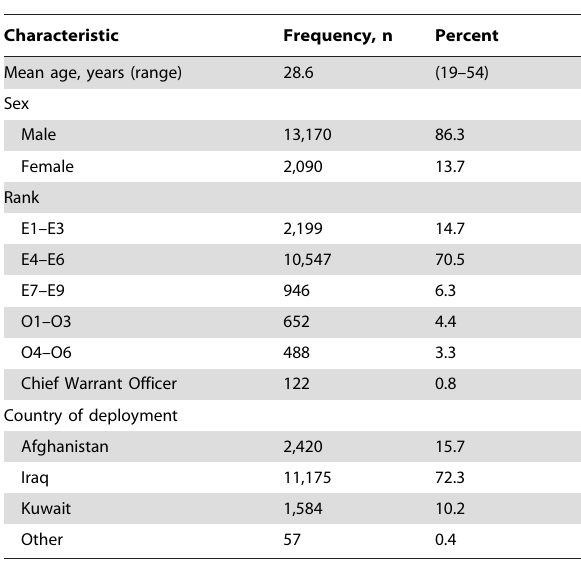
Table 2. Multivariate negative binomial regression of the association between rate of self-reported respiratory infection and covariates, voluntary respiratory questionnaire data Jan